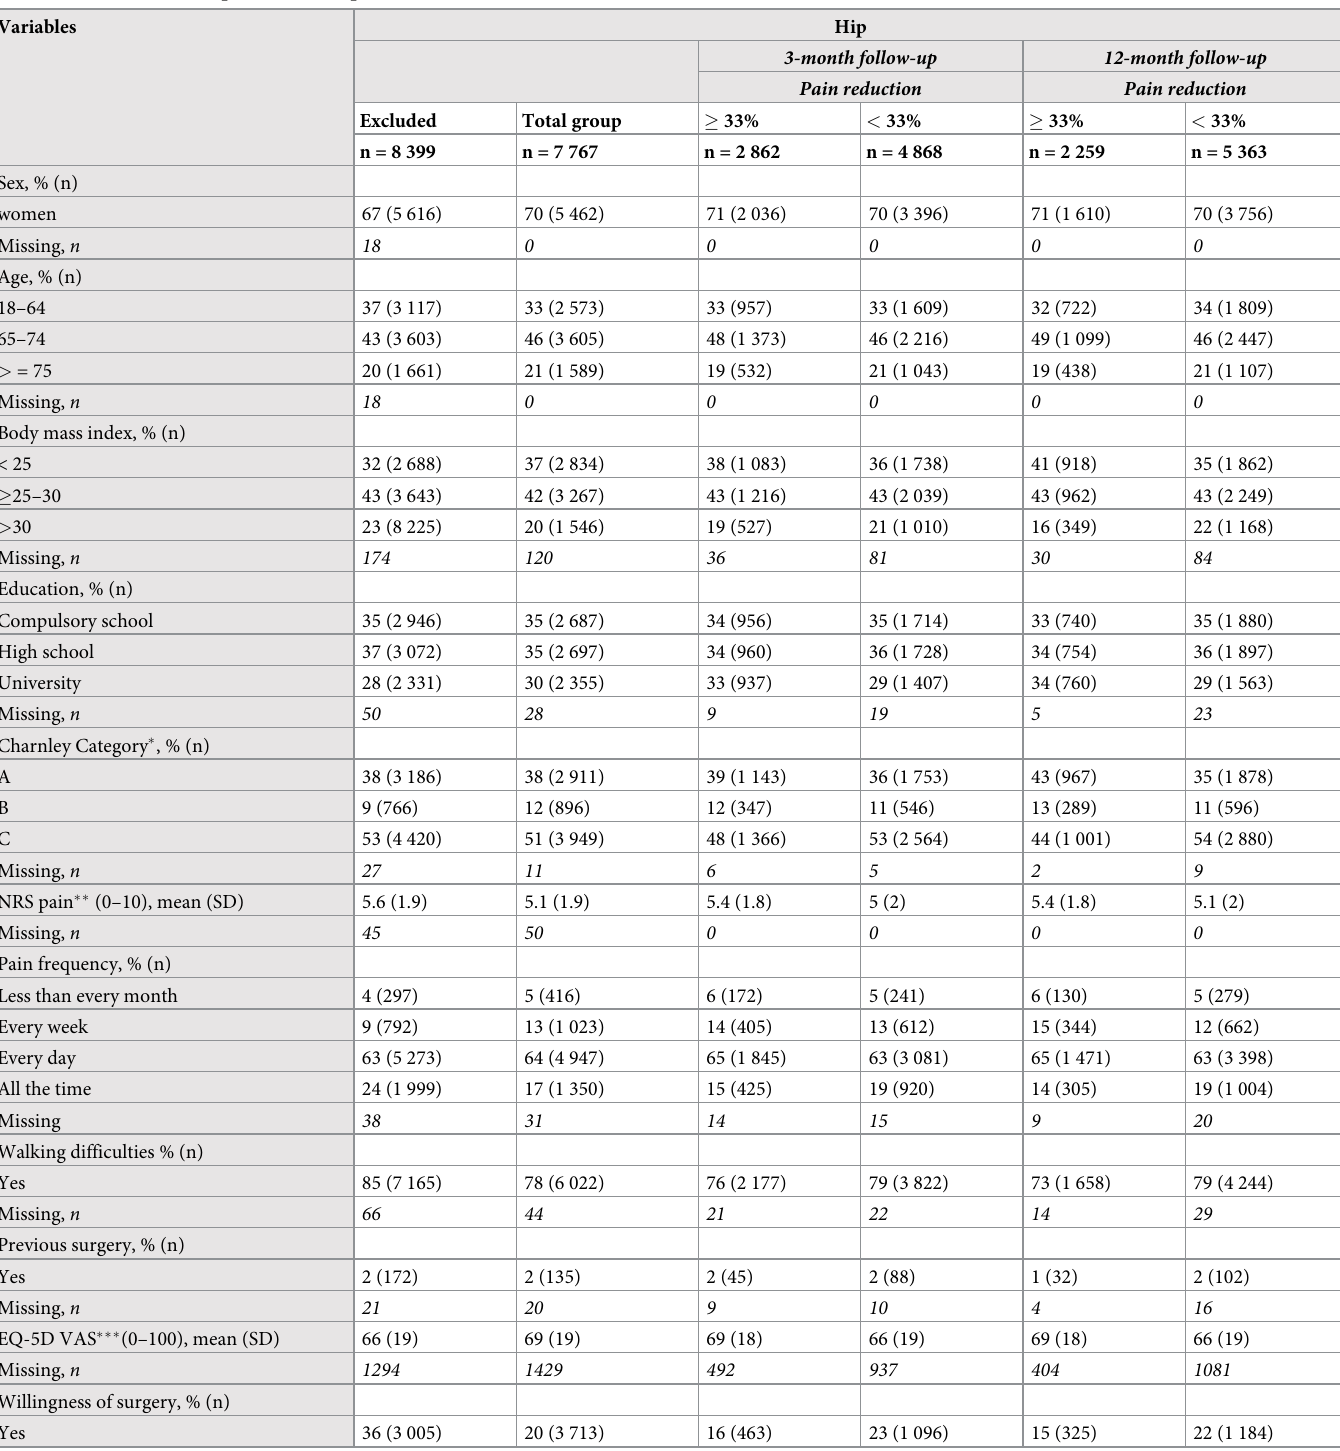
Table 2. Characteristics of patients with hip OA (n =